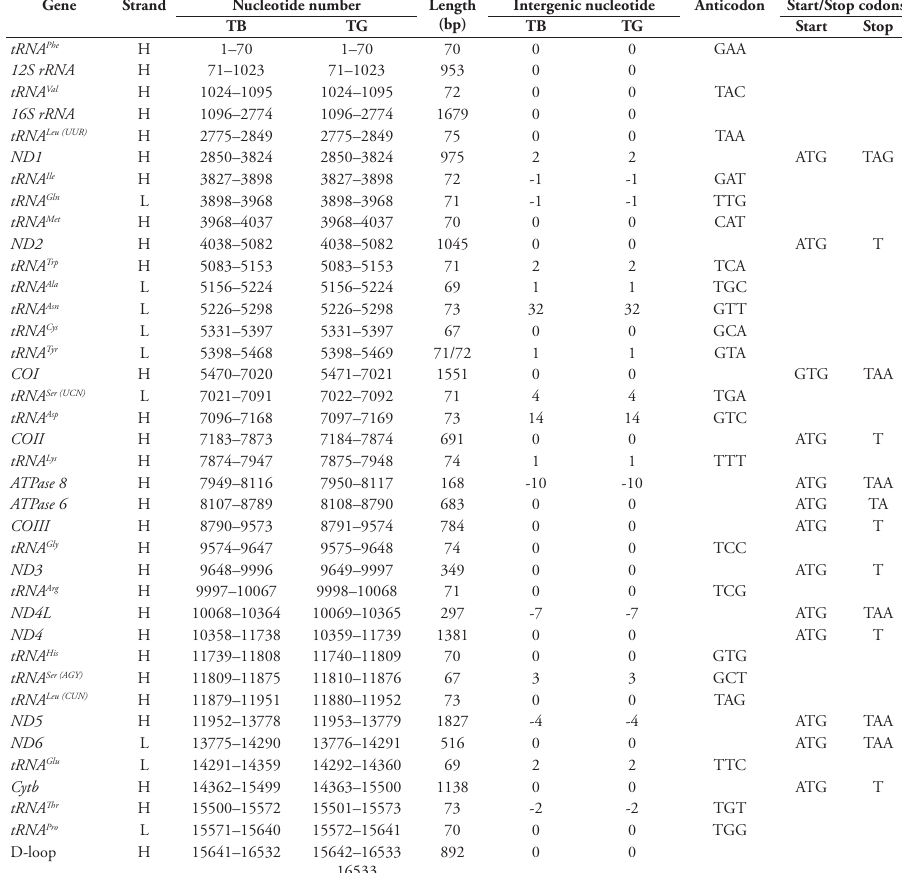
Table 1. Organization of mitochondrial genome of T. brachyrhabdion (TB) and T . gracilis (TG). H refers to the majority strand and L refers to the minority strand. Position numbers refer to positions on the majority